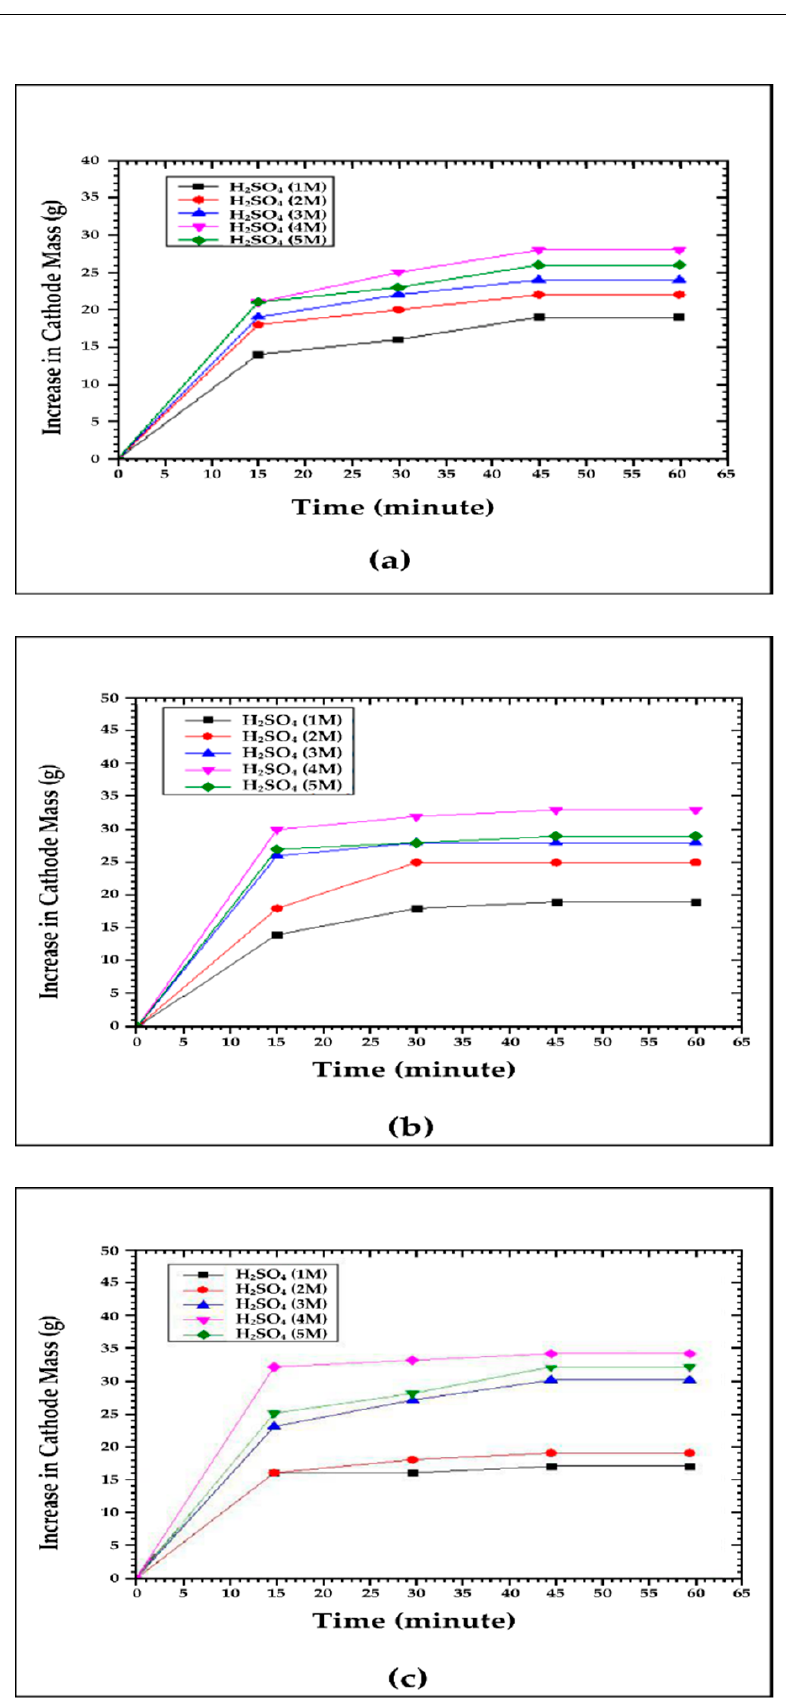
Figure 3. Cathode mass increase ( a ) 6 V, ( b ) 9 V, and ( c ) 12 V at various sulfuric acid concentrations.